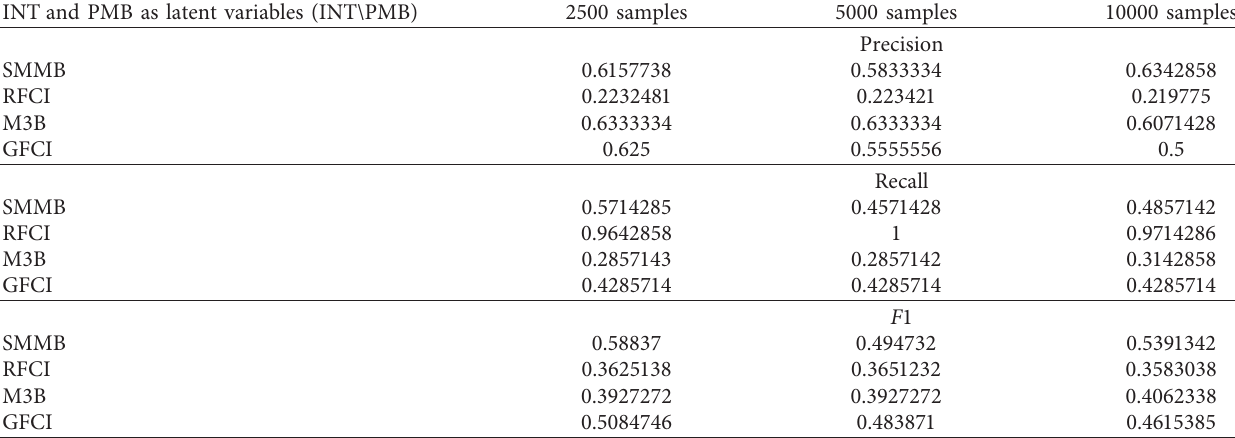
Table 3: When INTand PMB are used as latent variables, SMMB algorithm is compared with RFCI, M3B, and GFCI algorithms in accuracy, recall rate, and F 1 value.